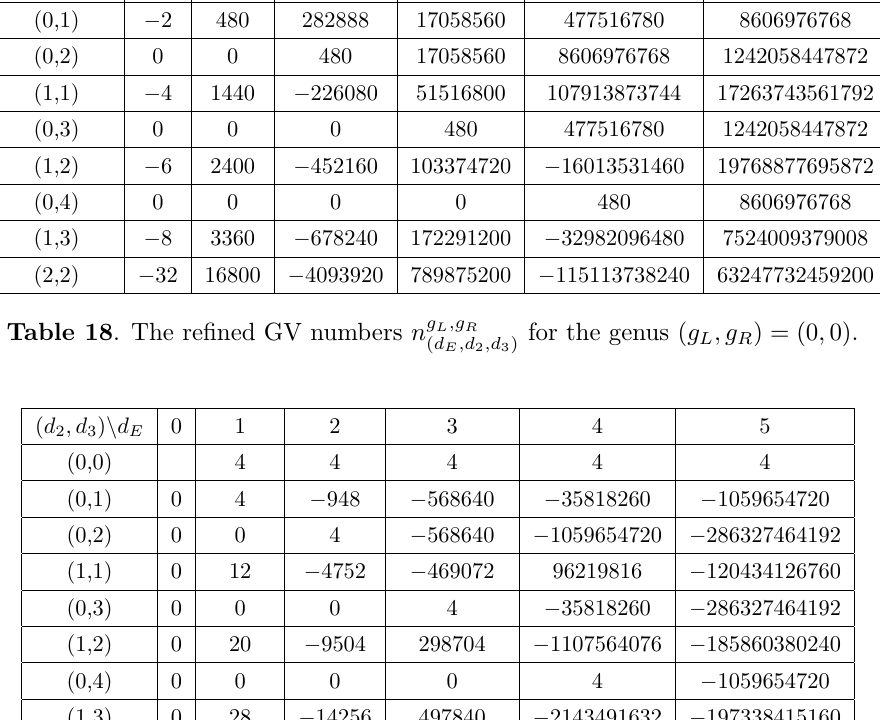
Table 19 . The refined GV numbers n g L ,g R